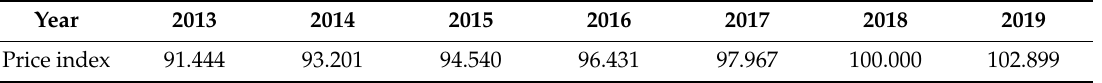
Table 2. Index for vehicle manufacturer suggested retail price (MSRP) adjustment [33].